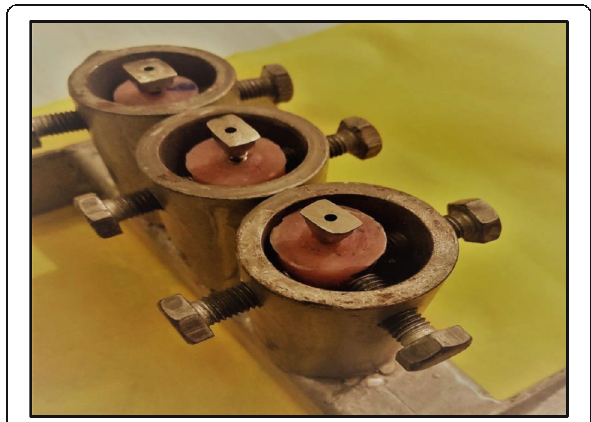
Fig. 1 Customized rigid mounting jig with fixating screws and the samples